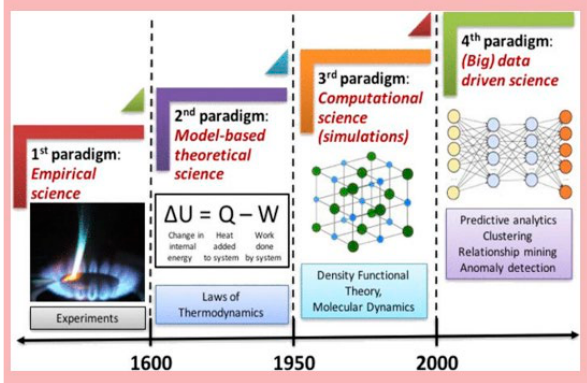
Figure. The four paradigms of science: empirical, theoretical, com- putational, and data-driven. Image from Agrawal and Choudhary 10